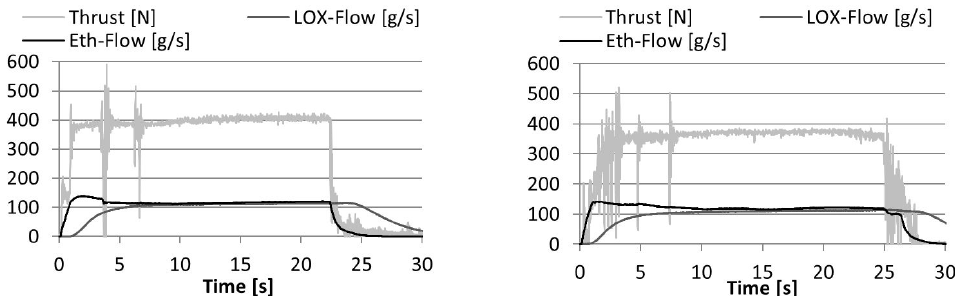
Figure 28. Damage to the graphite used in the steel combustion chamber during hot tests ( left ) and crack that occurred in the OCMC shell due to a local overload resulting from damage to the graphite ( right ).